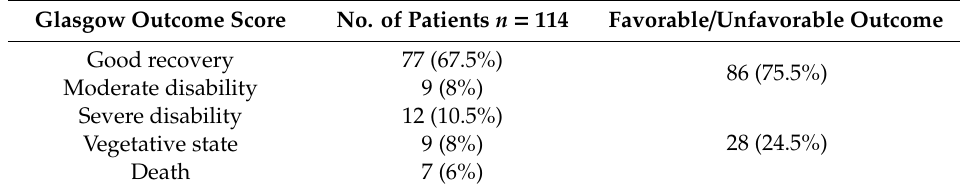
Table 3. Surgical treatment outcome of patients three months after subarachnoid hemorrhage (SAH) from ACoAA; GOS after three months.